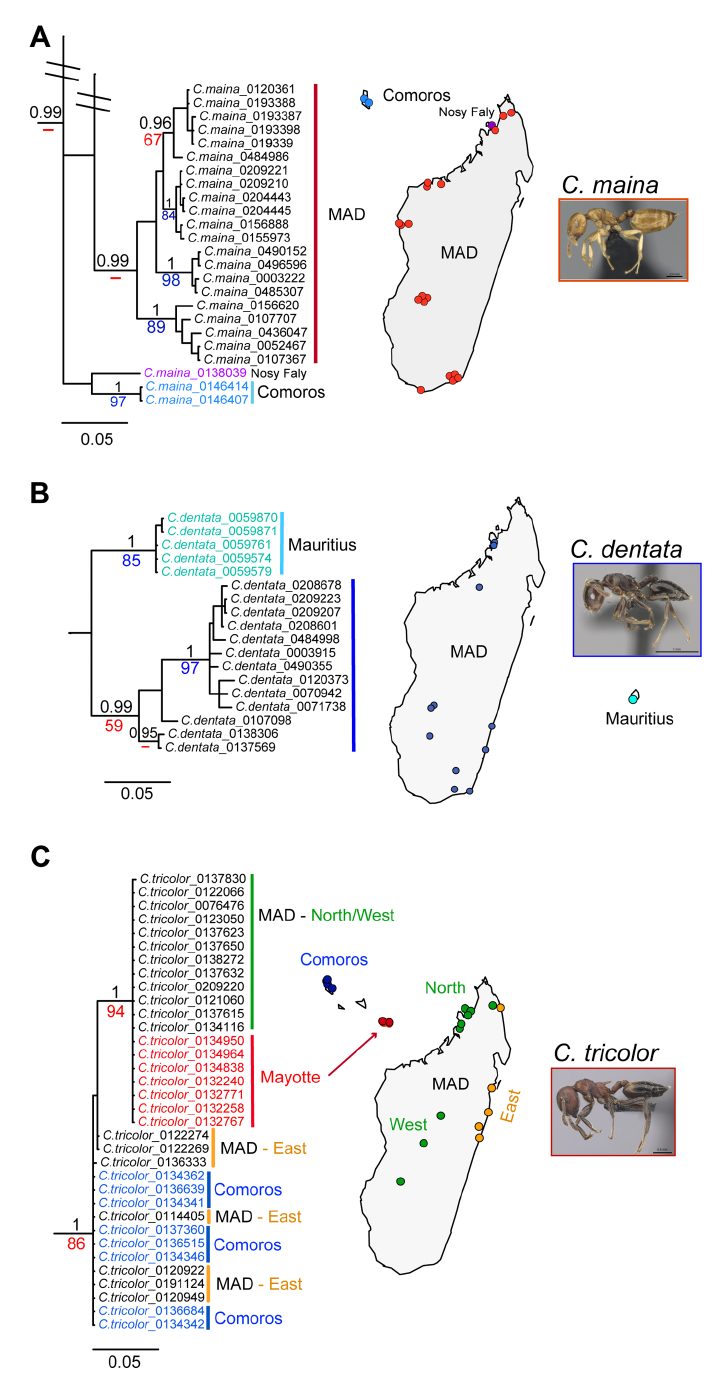
Fig. 2. Relatedness of populations between Madagascar and the wider Malagasy region. Subsets of the same phylogeny as shown in Fig. 1, with broad geographical origin of sequenced individuals mapped onto the tree for: A. Crematogaster maina sp. nov. B. Crematogaster dentata stat. nov. C. Crematogaster tricolor stat. rev. Support values in black represent posterior probabilities (pp), those in blue ML bootstrap values > 70 and those in red ML bootstrap values < 70. Values pp < 0.96 are not shown; nodes not present in the ML analysis are represented by a dash instead of a bootstrap value. The scale bar shows nucleotide changes per base pair. Distance between Madagascar and Islands is not drawn to scale. Appended numbers on taxon labels represent CASENT#’s of respective voucher